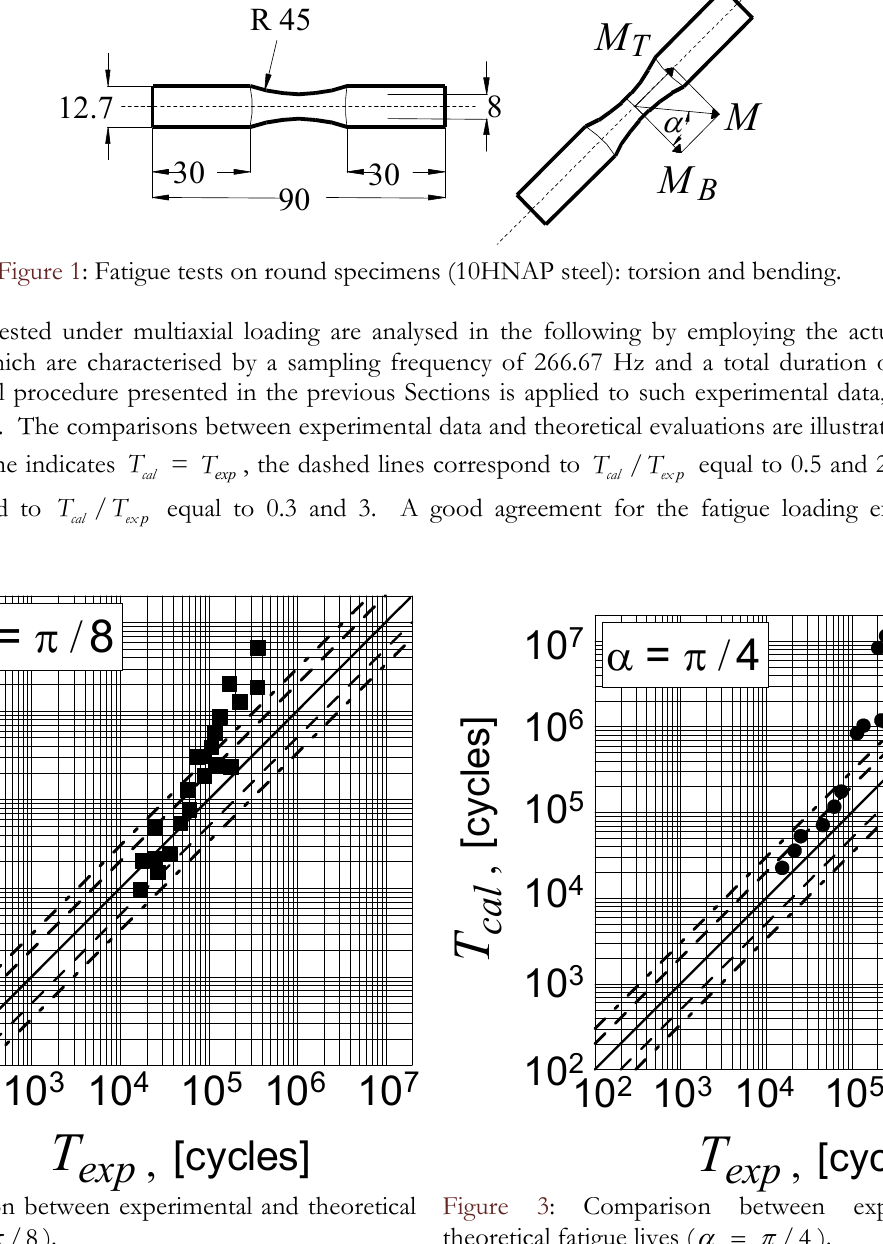
Figure 2: Comparison between experimental and theoretical fatigue lives ( /8   ).